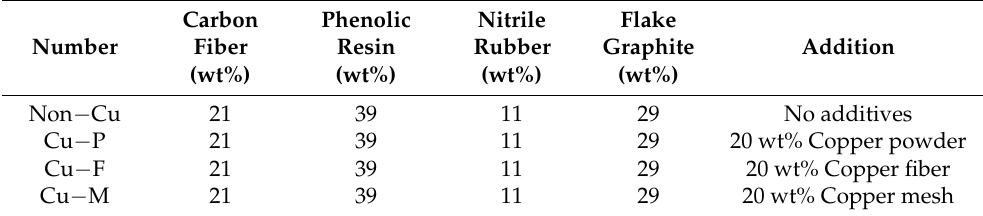
Table 2. The ratio of raw materials.